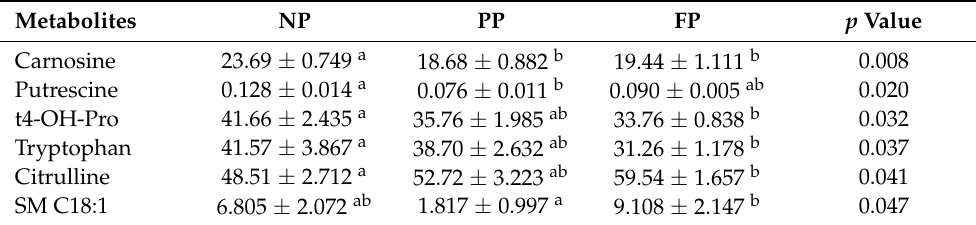
Table 2. Plasma significant metabolites (µM; mean ± standard error) of bulls in the rearing phase submitted to the different prenatal nutrition approaches (NP, PP, and FP) with their respective p values.